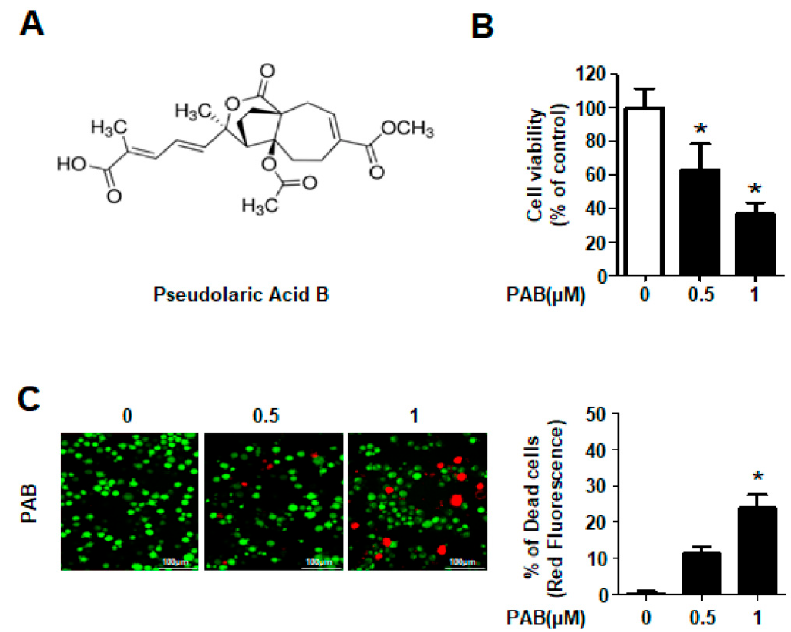
Figure 1. E ff ects of PAB on the survival of HN22 cell line. ( A ) The chemical structure of PAB. ( B ) HN22 cells were treated with DMSO or designated concentrations (0.5 and 1 µ m) of PAB for 24 h. Cells viability was examined by a trypan blue exclusion assay. ( C ) Live (green) and dead (red) cells were determined by Live / dead assay kit as mentioned in ‘Materials and Methods’ (magnification, X200). Columns represent means ± SD of triplicate determinations. (* p < 0.05).